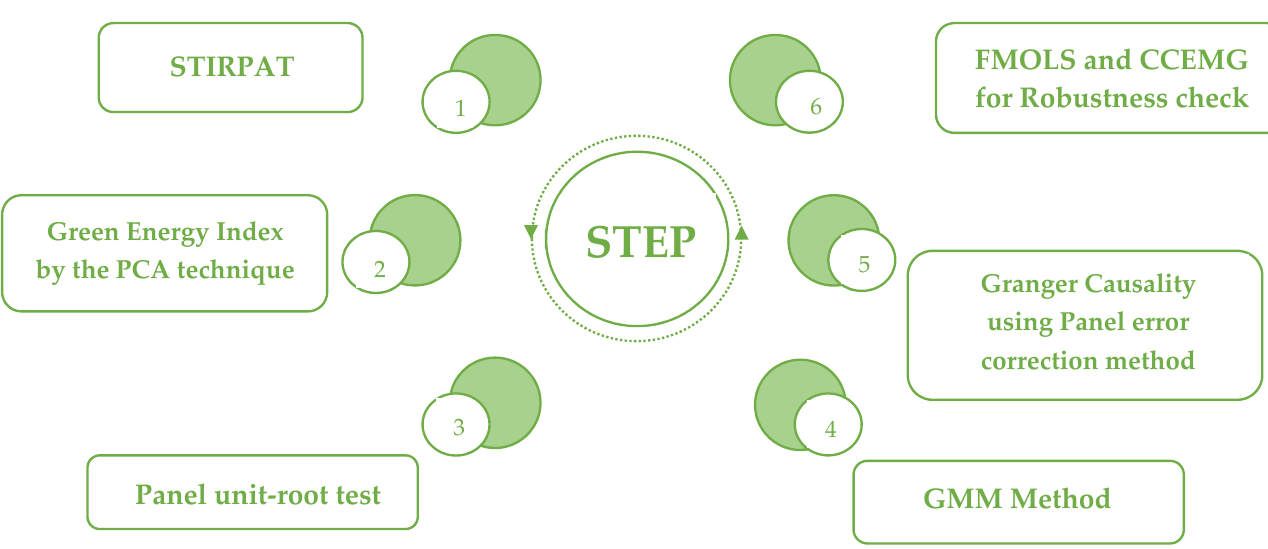
Figure 4. Conceptual framework of methodology. Source: Author(s) depiction.